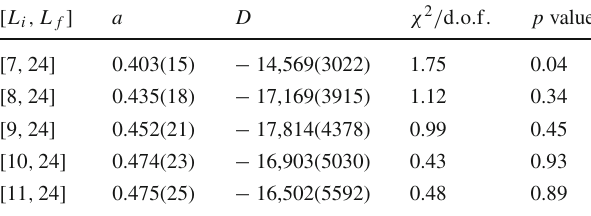
Table 5 Exemplary fit results for (cid:7) E 3 [ L , L ] a D χ 2 / d . o . f i f